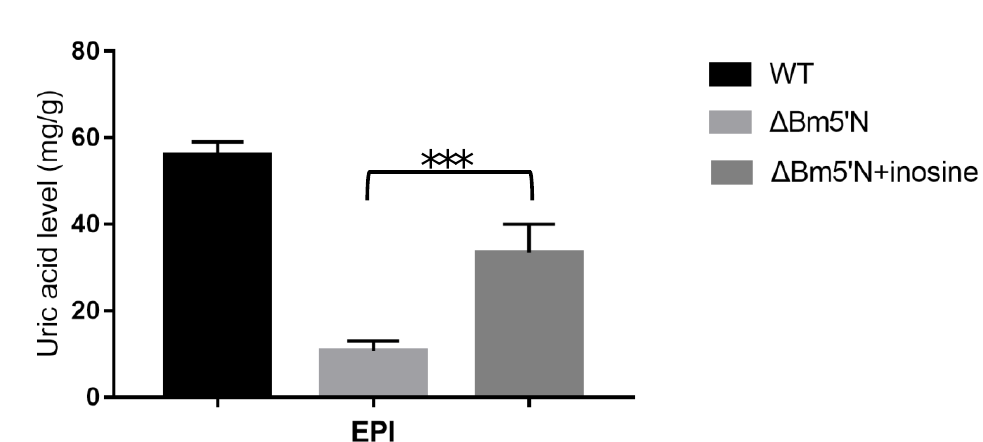
Figure 4. Bm5 (cid:48) N loss function decreases UA content. ( A ) UA concentration in the integument of WT and ∆ Bm5 (cid:48) N epidermis (EPI) of fifth instar larvae. ( B ) UA concentrations in fifth instar larvae fed UA precursors. Asterisks indicate significant differences with a two-tailed t -test: *** p < 0.001.